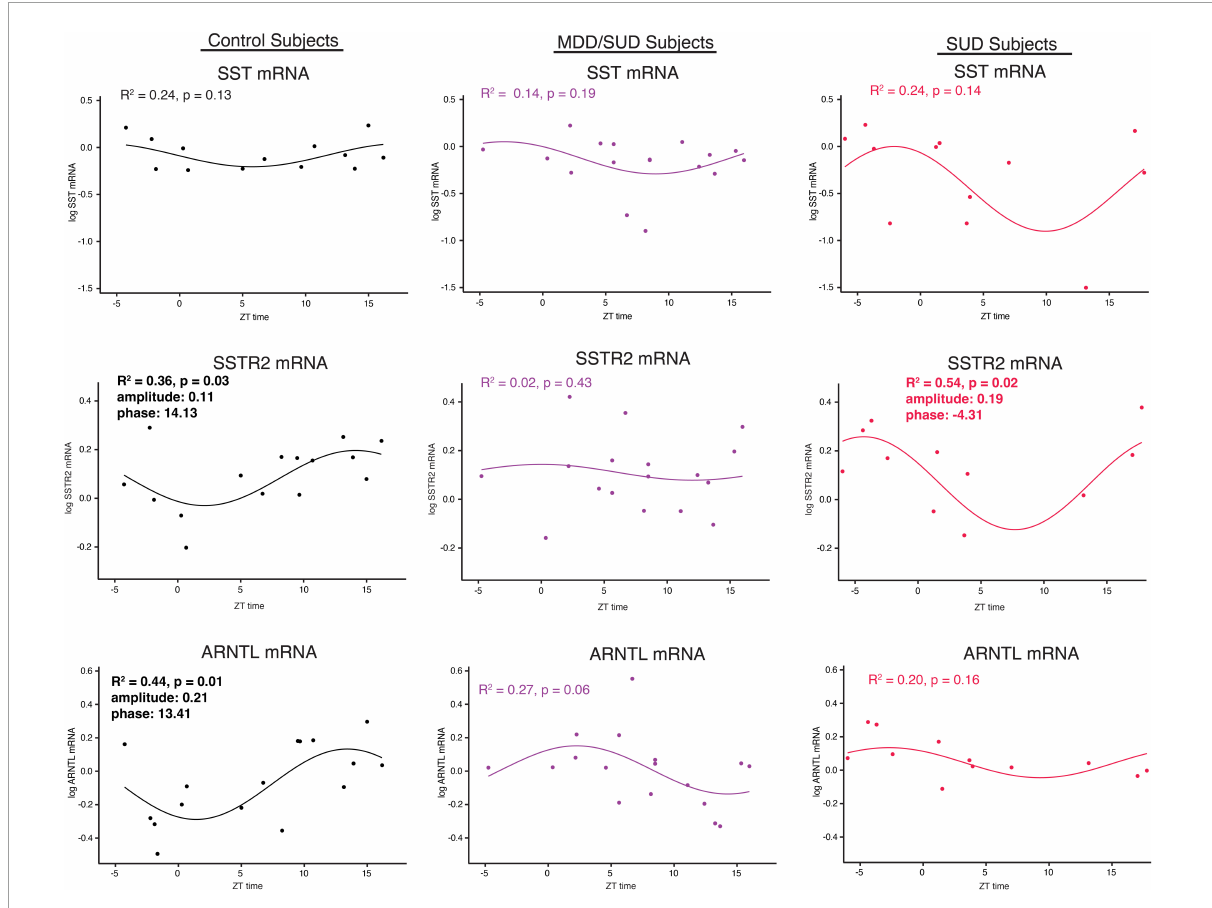
FIGURE6 Diurnal rhythms of SST Signaling and ARNTL gene expression. Diurnal gene expression rhythms for Sst signaling genes and Arntl demonstrating enhanced rhythms in subjects with SUD. Expression level values in the scatterplots are indicated on the y axis with each dot representing an individual subject and the x axis representing ZT time of death values. The colored lines represent the fit sinusoidal curve for each marker in each diagnosis group. R 2 values and corresponding p -values represent significance of fit for diurnal expression rhythms. Significant rhythms were observed in control subjects for Sstr2 and ARNTL expression, and enhanced rhythm and altered phase was detected for Sstr2 in subjects with SUD while Arntl rhythms were lost in subjects with SUD and MDD/SUD. Phase and amplitude estimates and p -values are indicated on each scatterplot for outcome measures with significant R 2